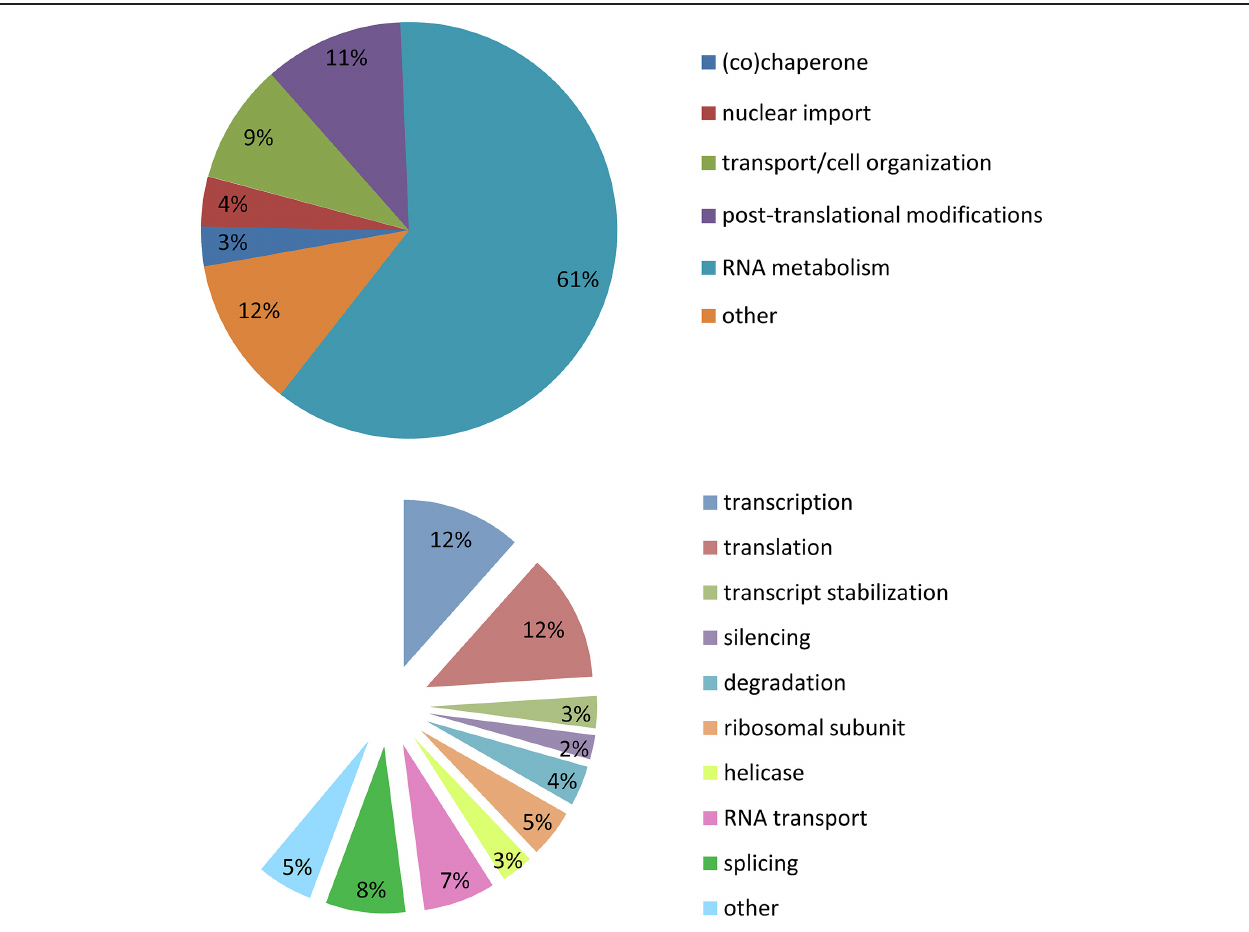
FIGURE 2 | Stress granule composition. Analysis of 154 publications between 1999 and 2014. (A) Cellular metabolism functions of proteins recruited to SGs. (B) Specific function in mRNA metabolism of proteins recruited to